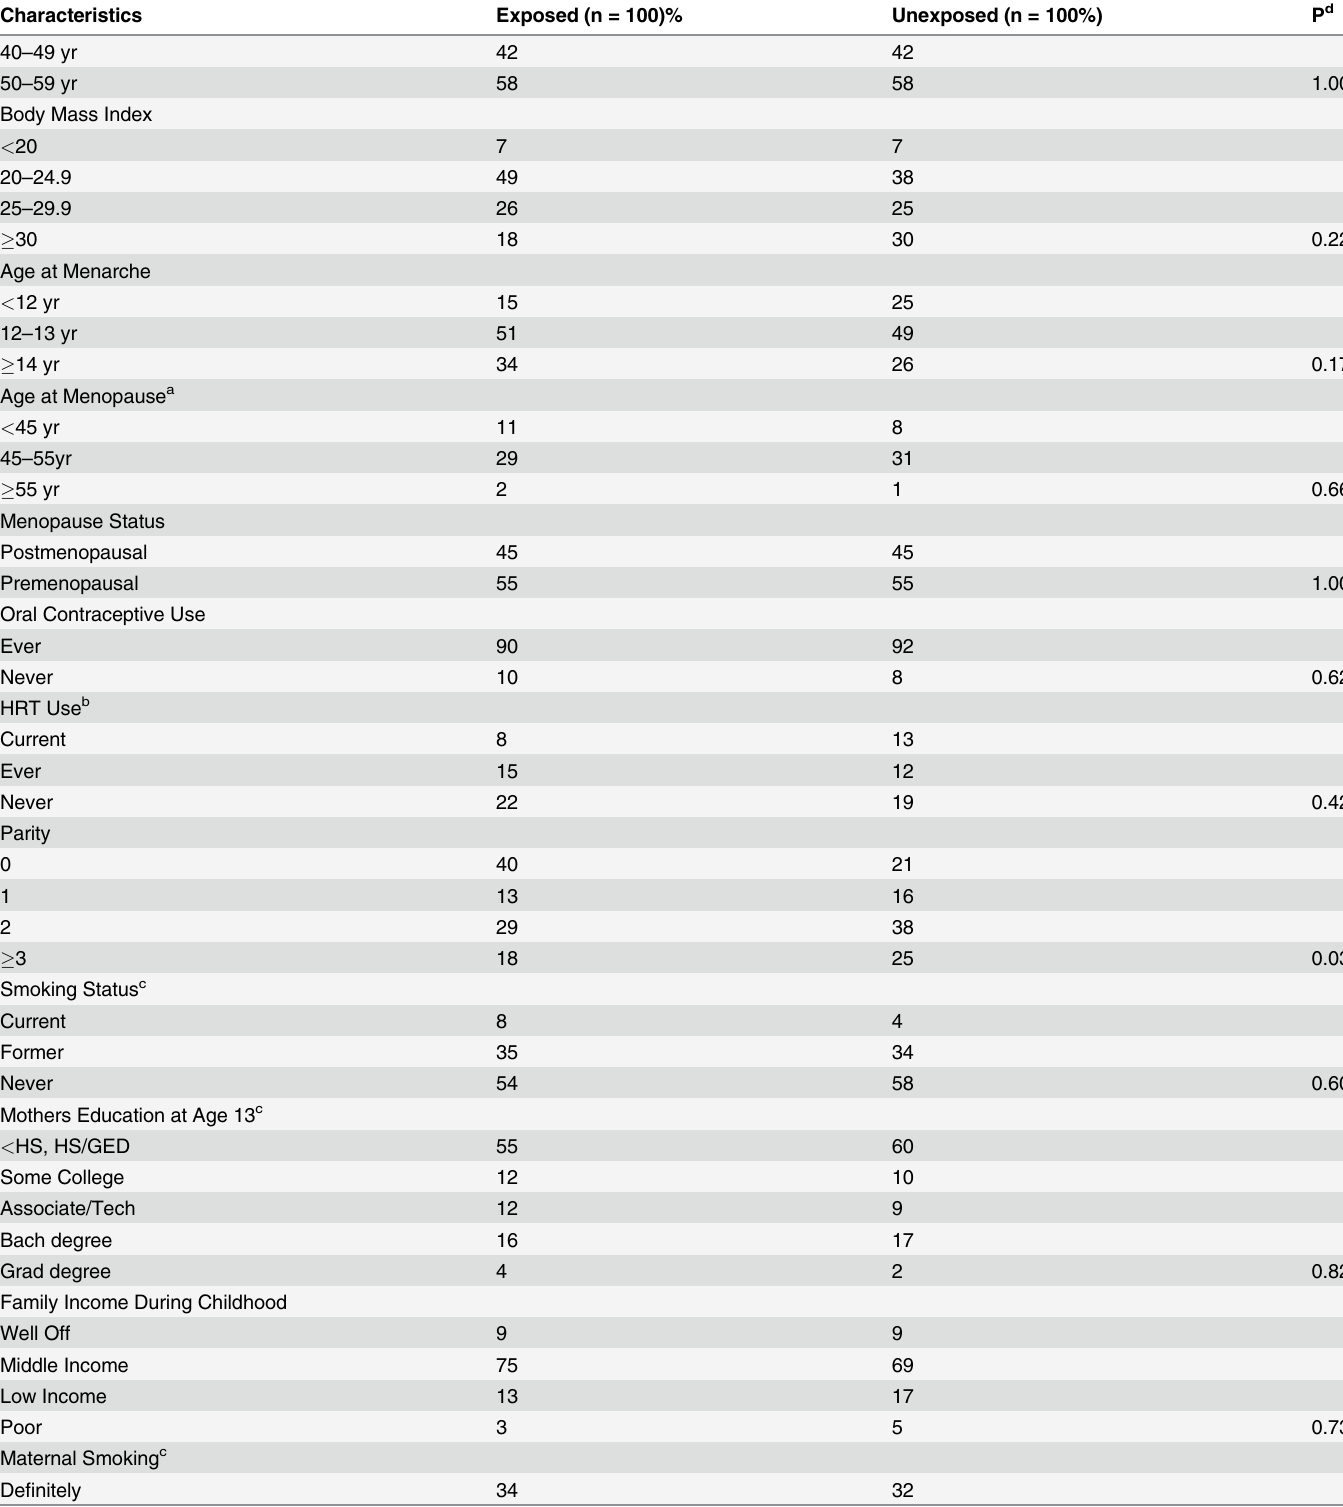
Table 1. Baseline characteristics of DES-exposed and unexposed women selected from the Sister